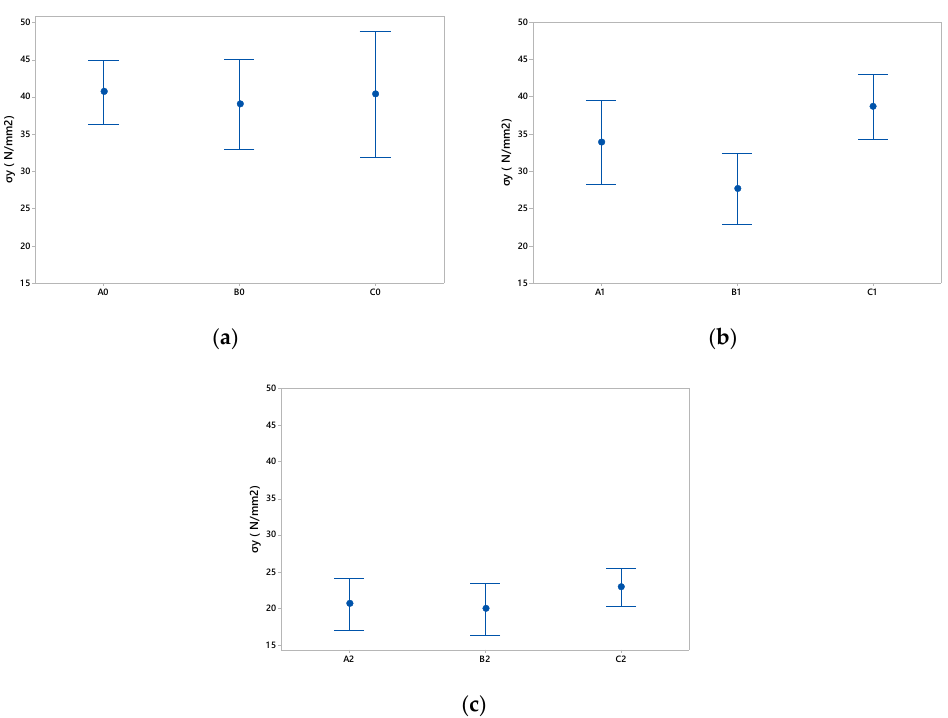
Figure 14. Comparative graph of the average results obtained for the yield stress of the three types of relief (A, B and C): ( a ) for the lower relief measure 0, 1.5 × 1.5 mm; ( b ) for the lower relief measure 1 of 3 × 3 mm; ( c ) for the relief measure 2 of 6 × 6 mm.